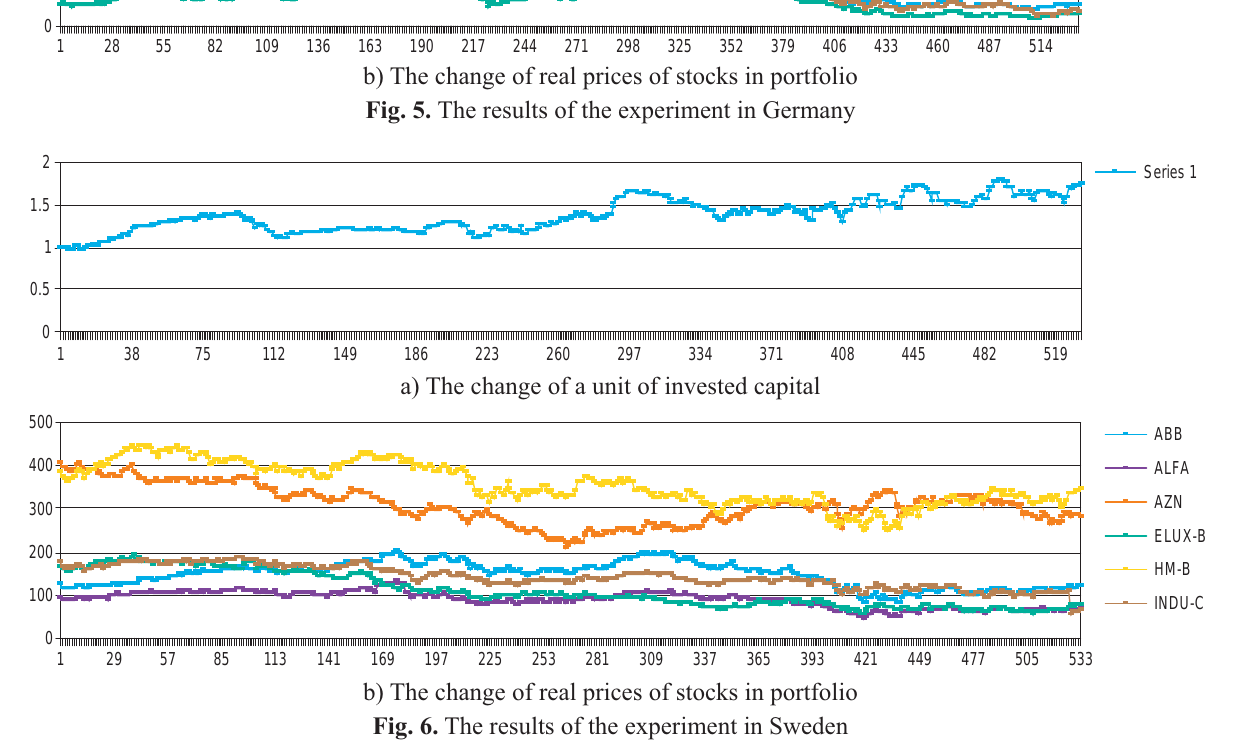
Fig. 5. The results of the experiment in Germany